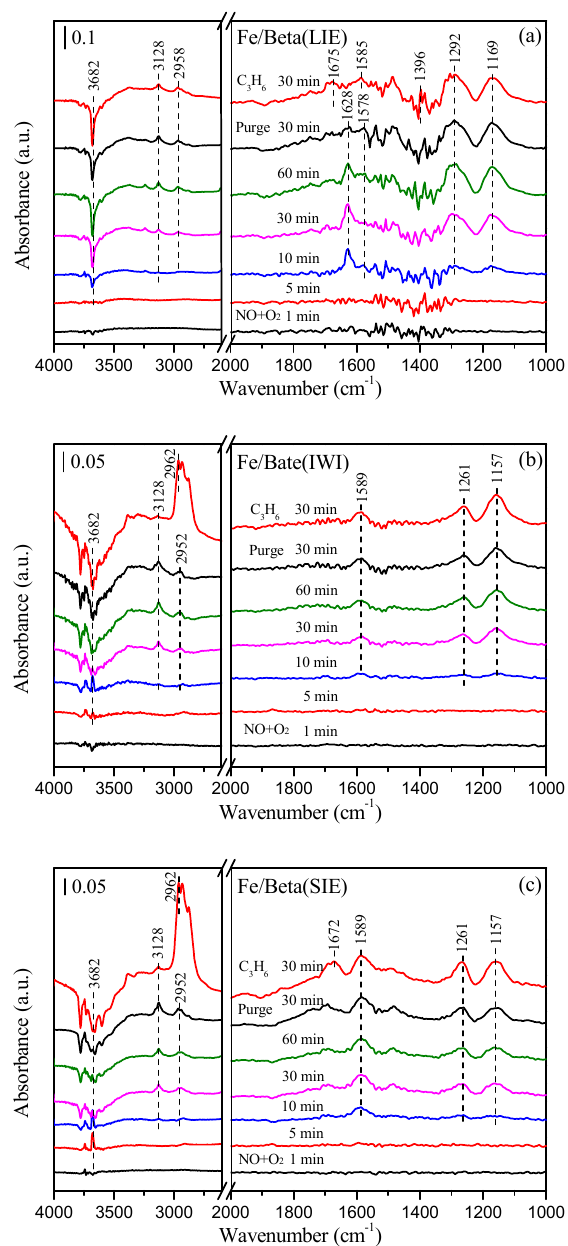
Figure 10. In situ DRIFT spectra measure on Fe/Beta catalysts prepared by different methods ( a ) Fe/Beta(LIE), ( b ) Fe/Beta(IWI) and ( c ) Fe/Beta(SIE) at 200 °C. Treatment: NO+O 2 adsorbed 60 min followed ( a ) Fe/Beta(LIE), ( b ) Fe/Beta(IWI) and ( c ) Fe/Beta(SIE) at 200 ◦ C. Treatment: NO+O 2 adsorbed by purged in N 2 30 min, then C 3 H 6 adsorbed 30 min. 60 min followed by purged in N 2 30 min, then C 3 H 6 adsorbed 30